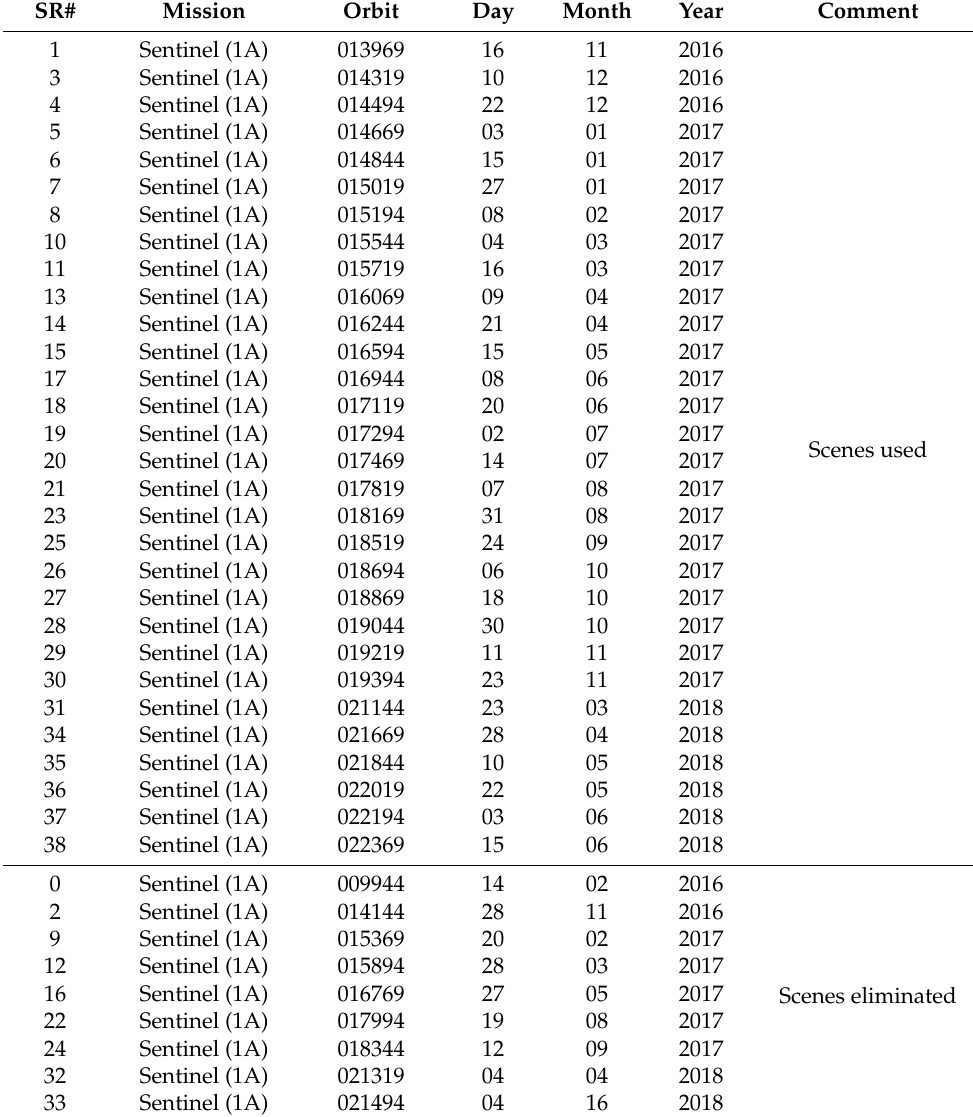
Table 1. Sentinel 1A SAR Acquisitions (ascending mode; Orbits: Path 72, Frame 73 and